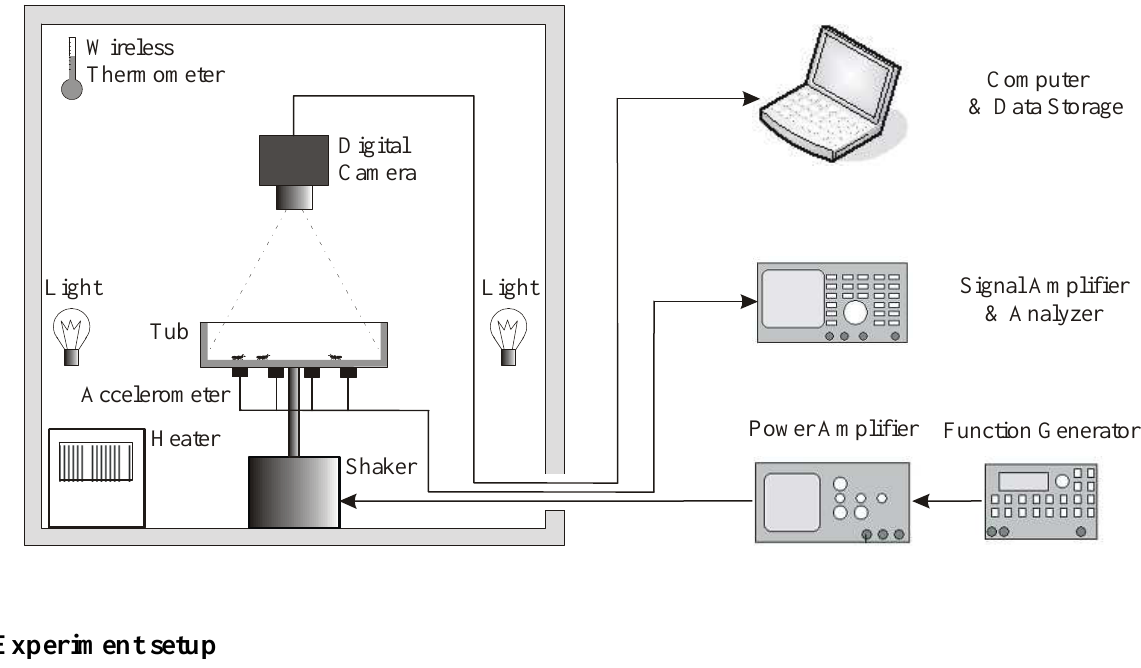
Figure 1. Schematic illustration of experiment setup for fire ant